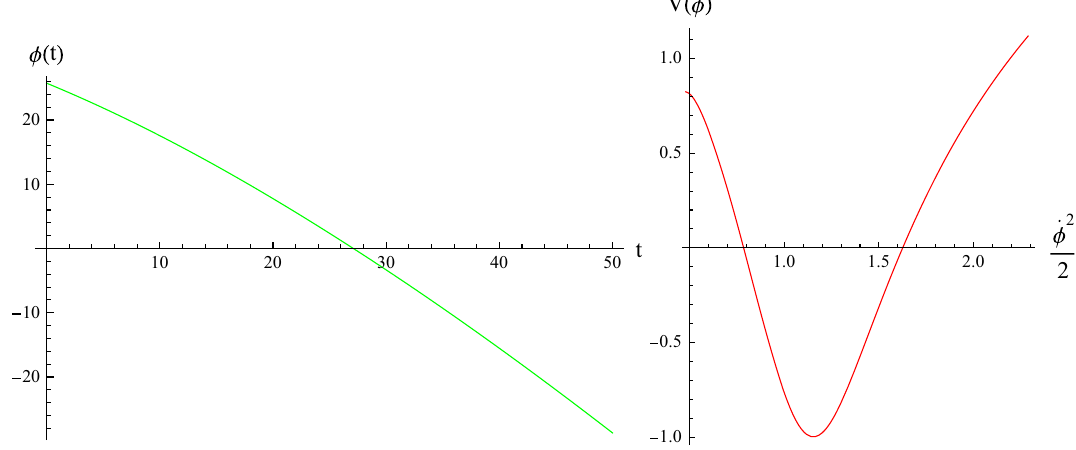
˙ φ 2 ( right ) for (cid:13) = − 1 2